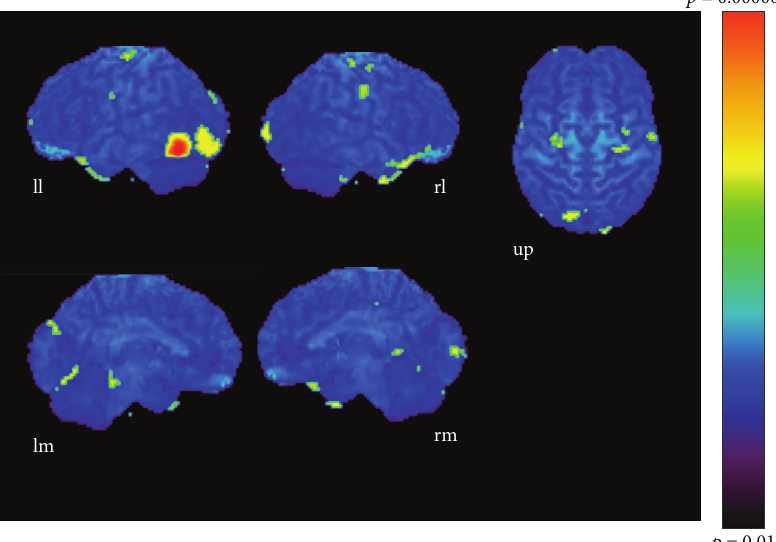
Figure 4: Complex-chord condition ( 𝑝 < 0.001 ). ll: lateral surface of left hemisphere; lm: medial surface of left hemisphere; rl: lateral surface of right hemisphere; rm: medial surface of right hemisphere; up: upper